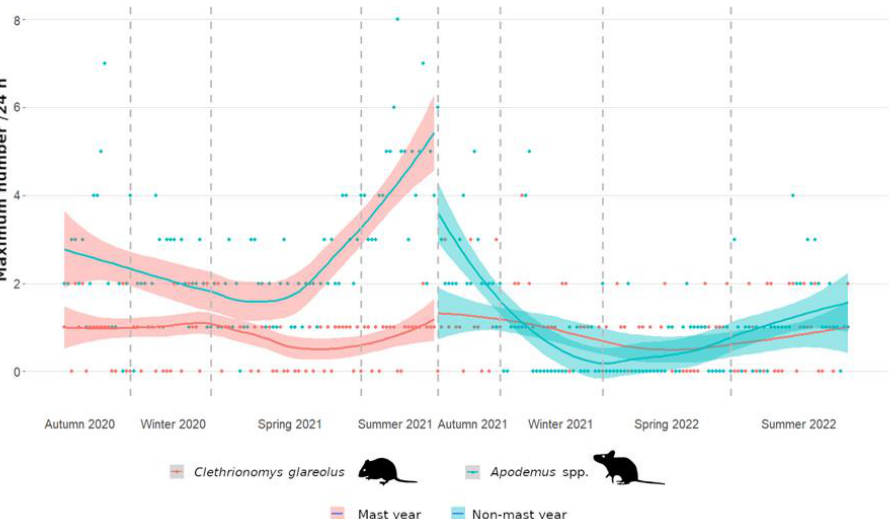
Figure 1. Population development of small forest rodents in an inner-alpine mixed forest. The frequency of Apodemus mice increased significantly in the mast year, whereas this was not the case for bank voles, Clethrionomys glareolus . In the non-mast year, the population of Apodemus mice collapsed.